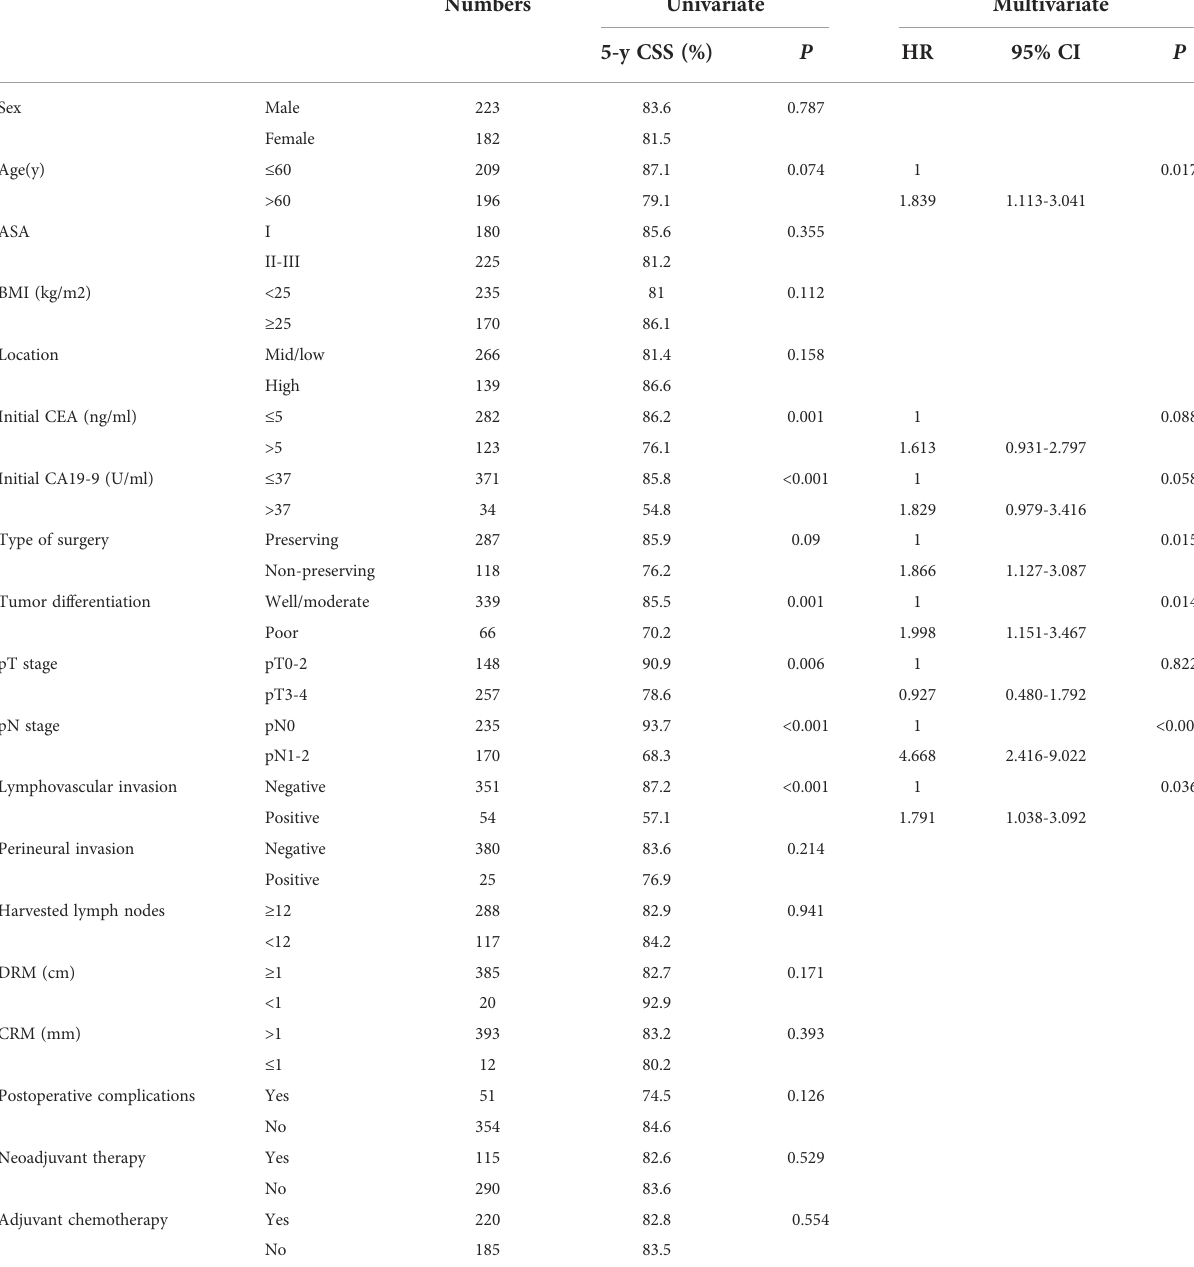
TABLE 6 Univariate and multivariate analyses of prognostic factors for cancer-speci fi c survival